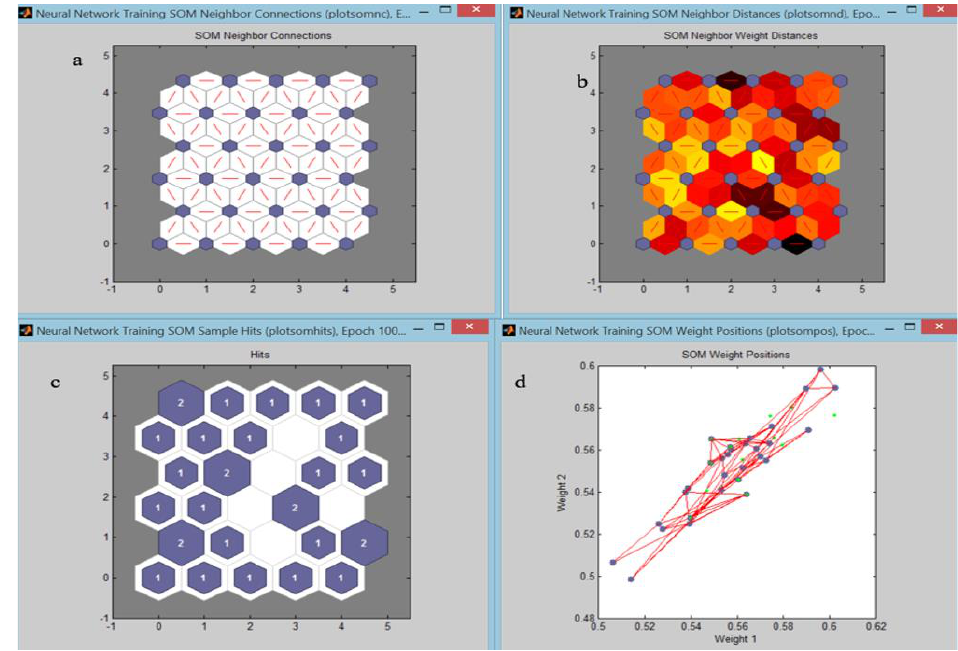
Figure 7. SOM training clustering performances.